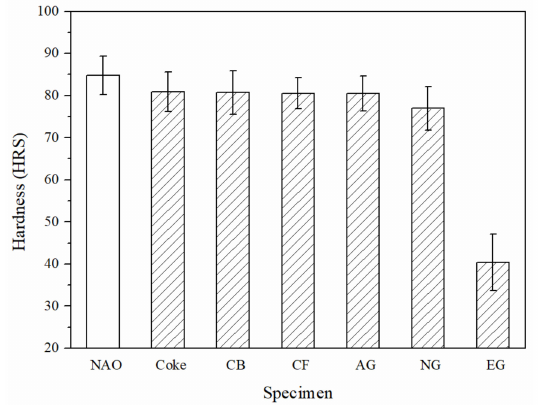
Figure 3. The hardness of specimens.